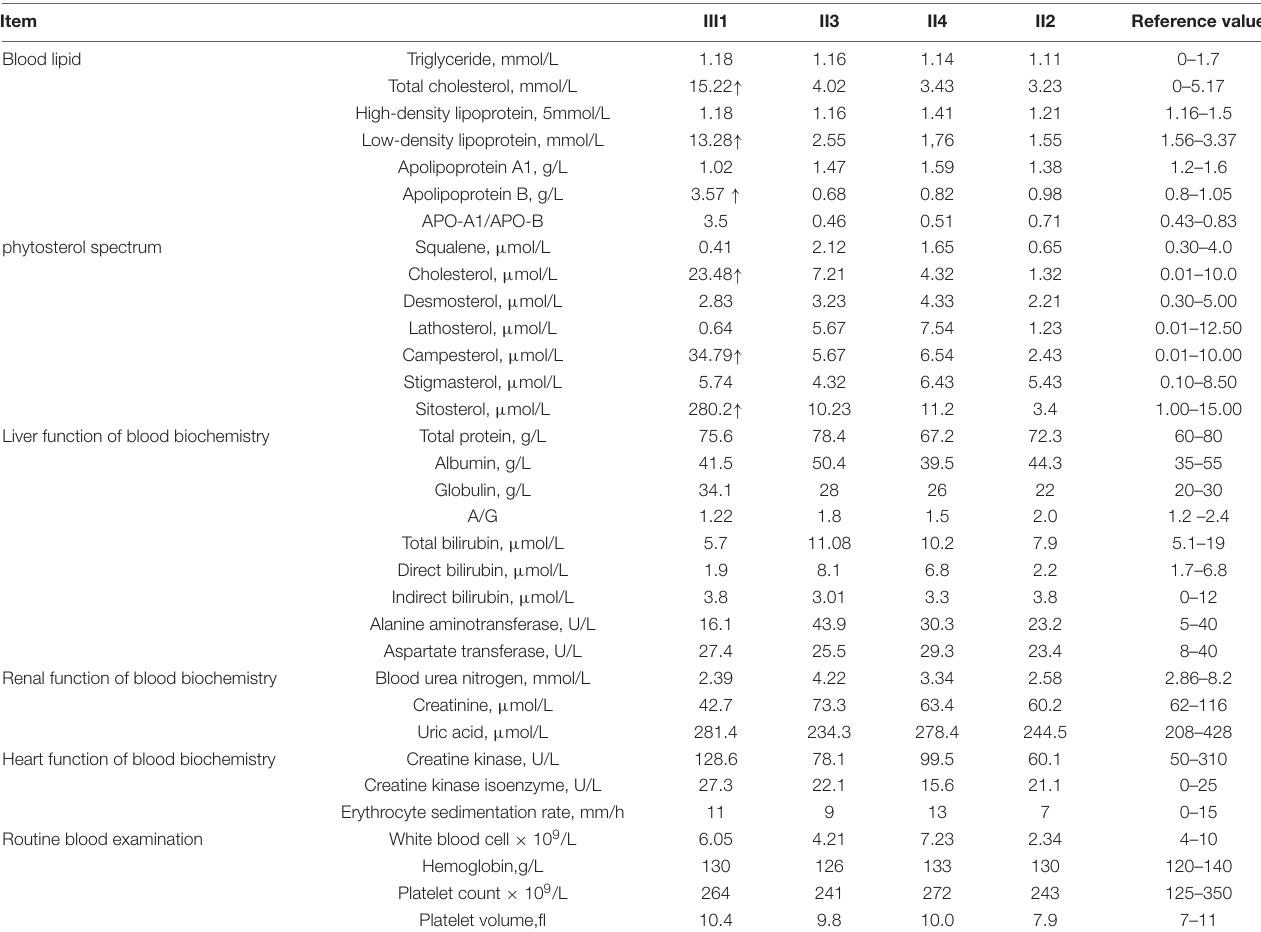
TABLE 1 | Biochemical indicators of family members with sitosterolemia.